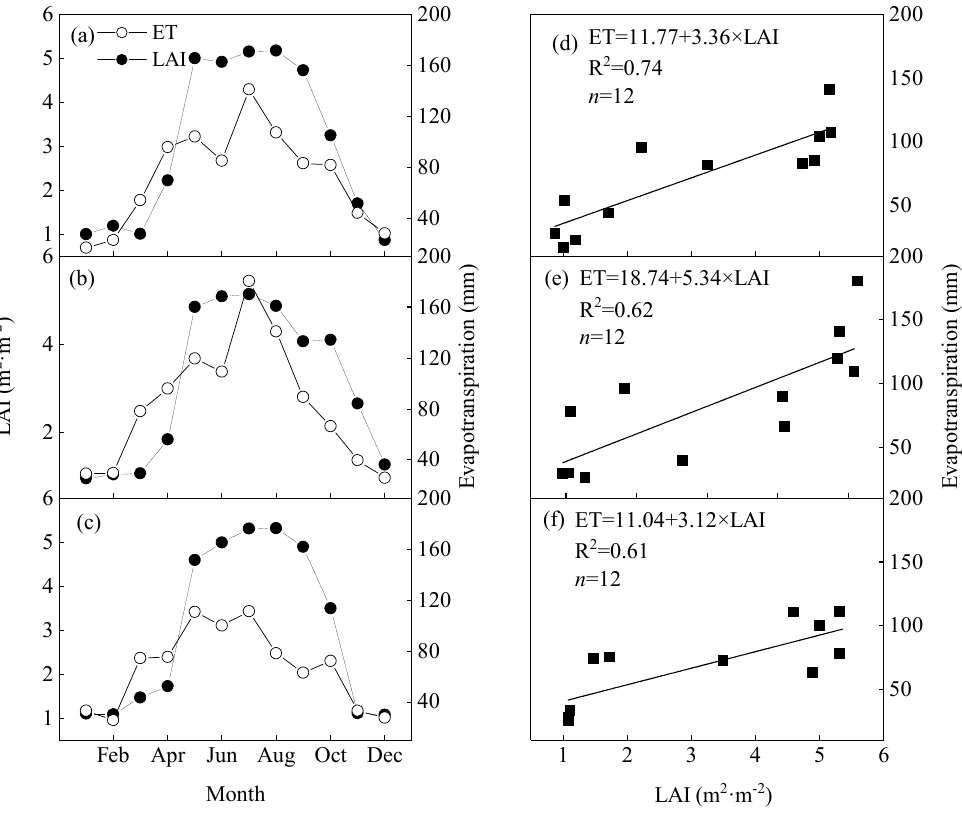
Figure 5. The relationship between ( a – c ) leaf area index (LAI) and ( d – f ) actual evapotranspiration (ET) from 2012–2014.